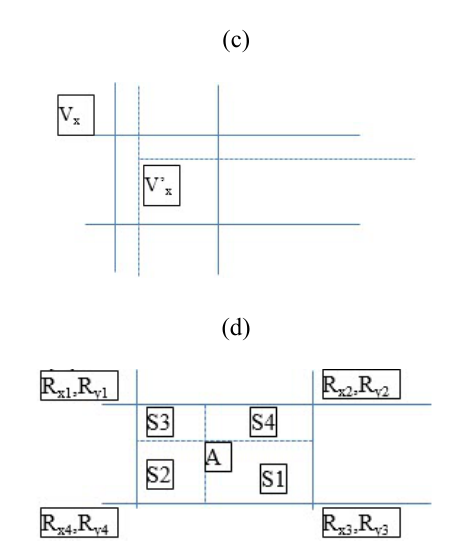
Figure 6. (a) Vertex-deviation in input image; (b) Grid cell; (c) Vertex of grid cell and intersection point; (d) Vertex of grid cell and a point inside grid cell.